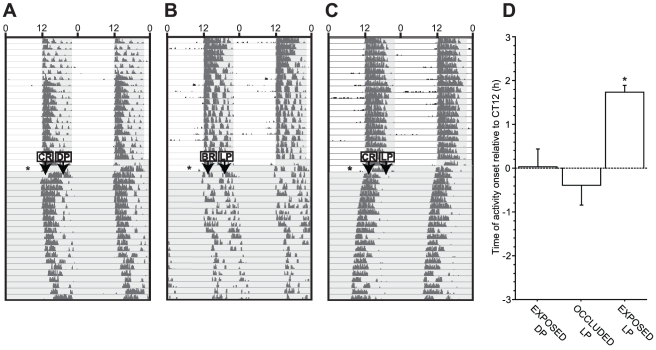
Occlusion of circadian light perception.Representative double-plotted locomotor activity records of Syrian hamsters in experiment 1. Clock time is indicated on the horizontal axis along the top of each actogram. Lights on/off are indicated by light and shaded areas of the actogram. Hamsters were blinded in the left eye via optic nerve transection (indicated by *), transferred to DD, and subjected at ZT19 to A a control dark pulse (DP) with a clear lens over the right eye (CR), B a 15 min light pulse (LP) with an occluder over the right eye (BR), or C a 15 min LP with a clear lens over the intact eye. D Mean (± s.e.m.) magnitude of the phase shift in activity onset as measured 5 days later. * p<0.001 vs. all other groups.